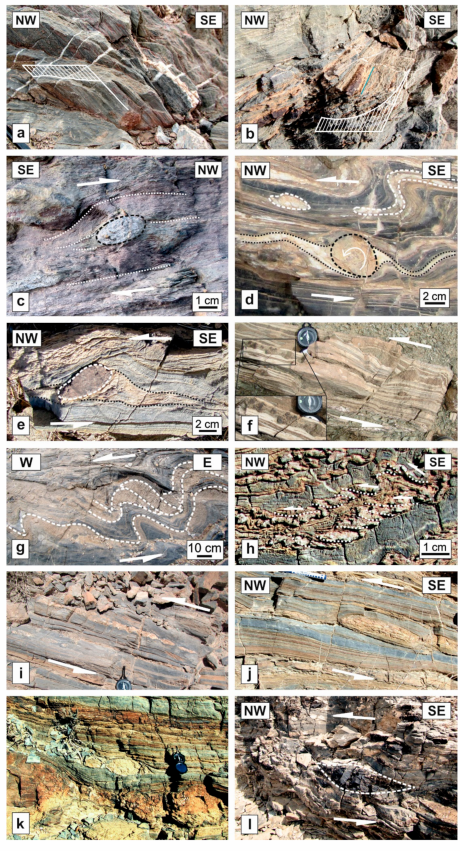
Figure 5. ( a ) Field photographs of foliation and lineation of the Faryadun shear zone [43]; ( b ) Foliation and lineation of the SW of the Esteghlal shear zone; ( c ) A calcite porphyroclast in schists of top- to-the NW Shurjestan shear zone; ( d ) Mesoscopic ankerite porphyroclasts in the XZ-plane of the calcite mylonites of the Faryadun shear zone with its light calcite mantle showing counter-clockwise rotation [34]; ( e ) A sinistrally rotated mesoscopic porphyroclasts in the XZ-plane of the Chah-e- Sefid shear zone [34]; ( f ) Mesoscopic porphyroclasts (left of the photograph) and shear band type fragmented porphyroclast (right of the photograph) in the XZ-plane of the Magasi shear zone which shows sinistral top-to-the NW deformation. The compass needle is 55 mm long and toward N; ( g ) S-shaped asymmetric folds and a mesoscopic duplex structure which have been produced by out-of-syncline and limb wedge thrusting in the XZ-plane of the sinistral top-to-the NW Faryadun shear zone [34]; ( h ) Mesoscopic duplex structure and asymmetric folds in the Chah-e-Sefid shear zone [43]; ( i ) Shearband quartzitic boudins in the North Esteghlal shear zone; ( j ) Shearband quartzitic boudins in the Chah-e-Sefid shear zone [34]; ( k ) Asymmetric boudins in the Chah-e-Sefid shear zone; ( l ) Asymmetric boudins in the Kuh-e-Sefid shear zone. See Figures 3 and 4 for their